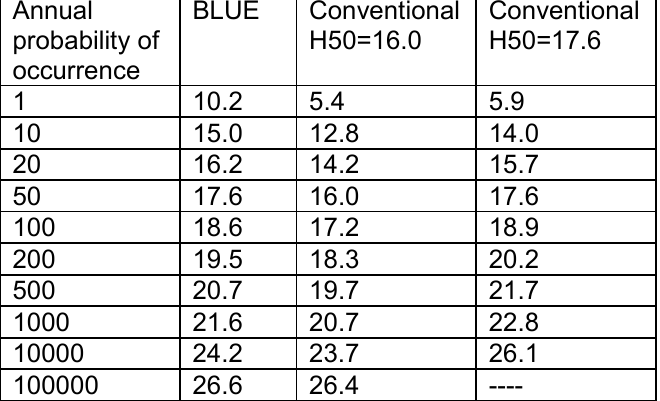
Table 2 Statistics relating to the depth of inundation at Windsor Annual BLUE Conventional probability of occurrence